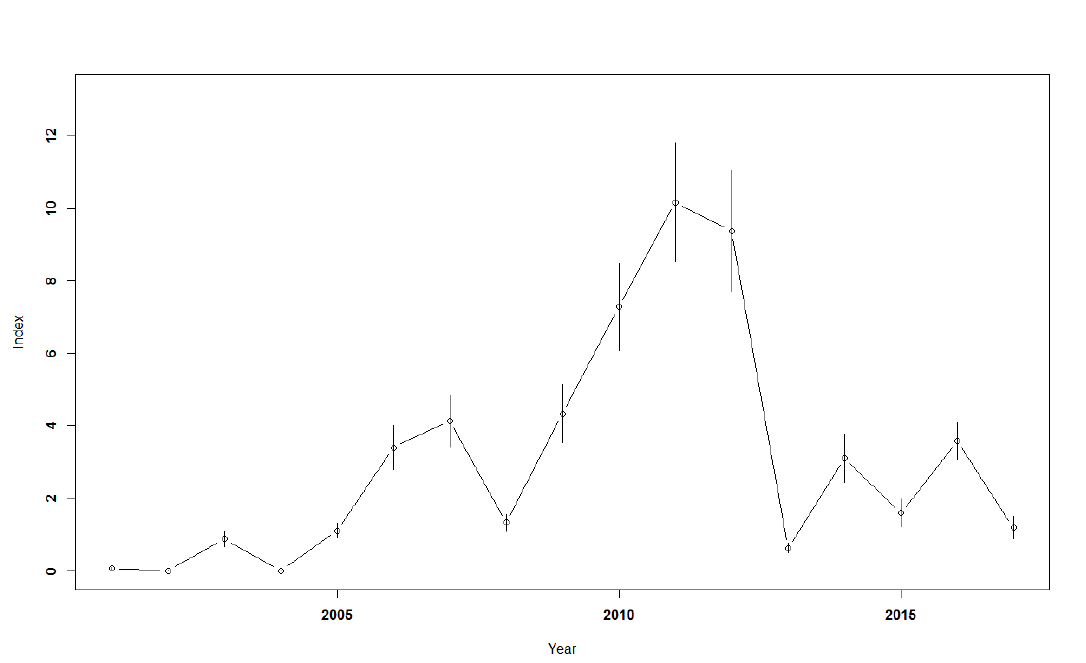
Figure 69. Index of relative abundance of horseshoe crab (delta mean catch per tow) developed from the South Carolina and fall portion of the SEAMAP survey with 95% confidence intervals.